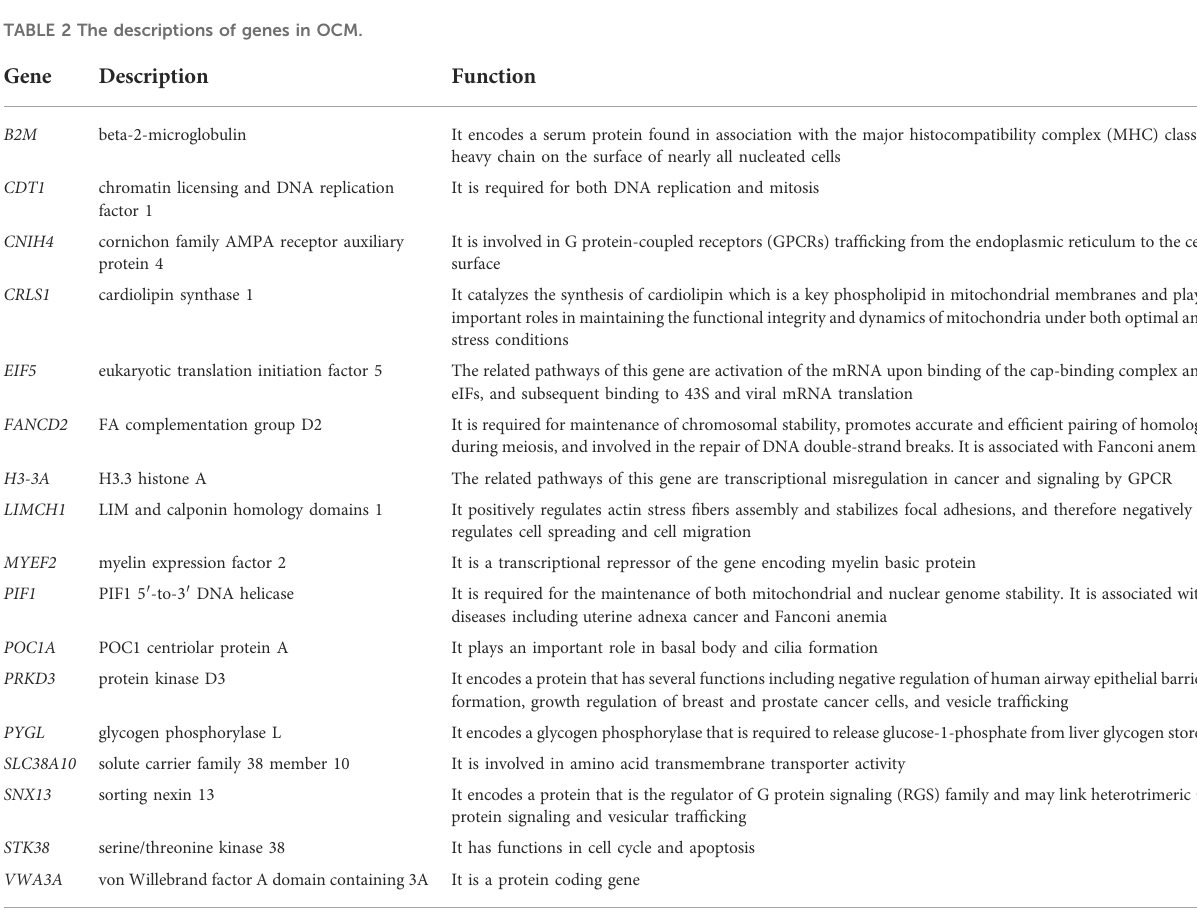
TABLE 2 The descriptions of genes in